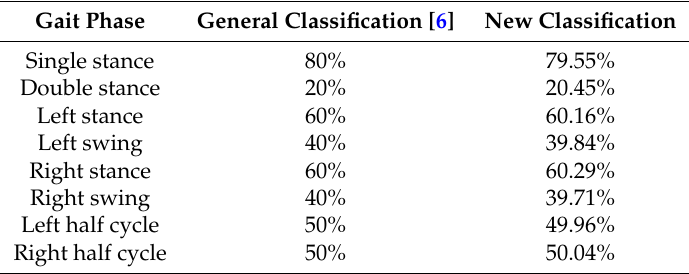
Table 4. The average main phase percentage comparisons of the general classification and the 3 new